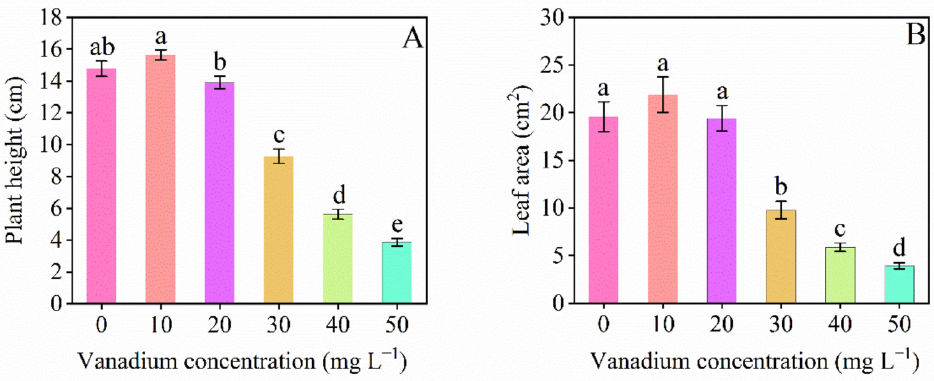
Figure 2. Effect of vanadium on plant height ( A ) and leaf area ( B ) in pepper seedlings. Means ± SE, n = 4, significant differences are exhibited by lowercase letters (at p < 0.05), according to Fisher’s least significant difference